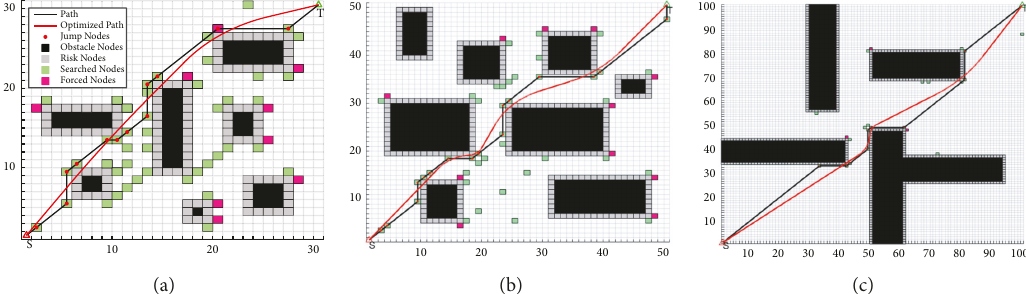
Figure 16: The improved A ∗ algorithm in this paper. (a) 30 ∗ 30. (b) 50 ∗ 50. (c) 100 ∗ 100.